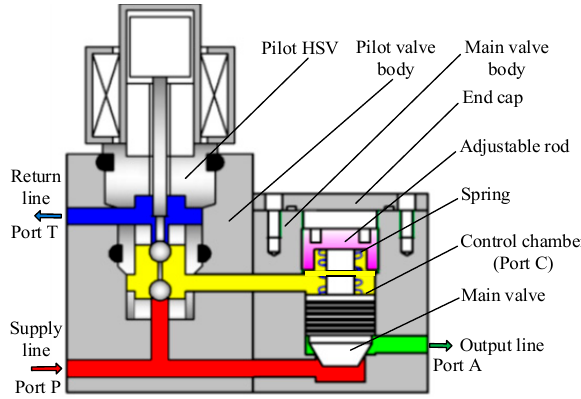
Figure 1. Schematic diagram of the AMOHSV.